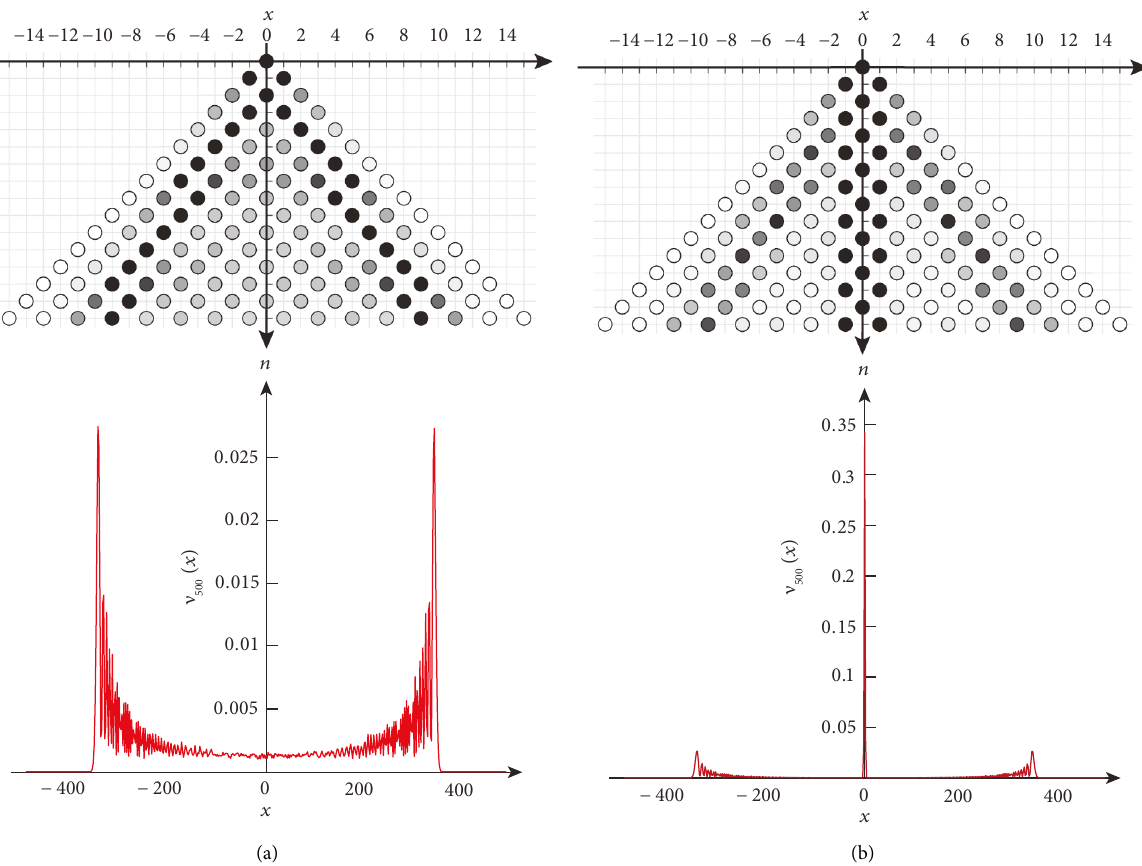
Figure 2: Graphical expressions of QWRW for (a) example 1 (site-homogeneous model) and (b) example 2 (one-defect model). The upper figure of each panel illustrates the space-time diagrams of the probability distribution. Circular markers are located at the coordinates ( n, x ) such that ] n ( x ) > 0 with their color indicating the value of ] n ( x ) . The darker the color is, the larger the value of ] n ( x ) is. The lower figure of each panel shows probability distribution of QWRW ] n ( x ) at the time instant n � 500, which exactly matching the distribution of the original